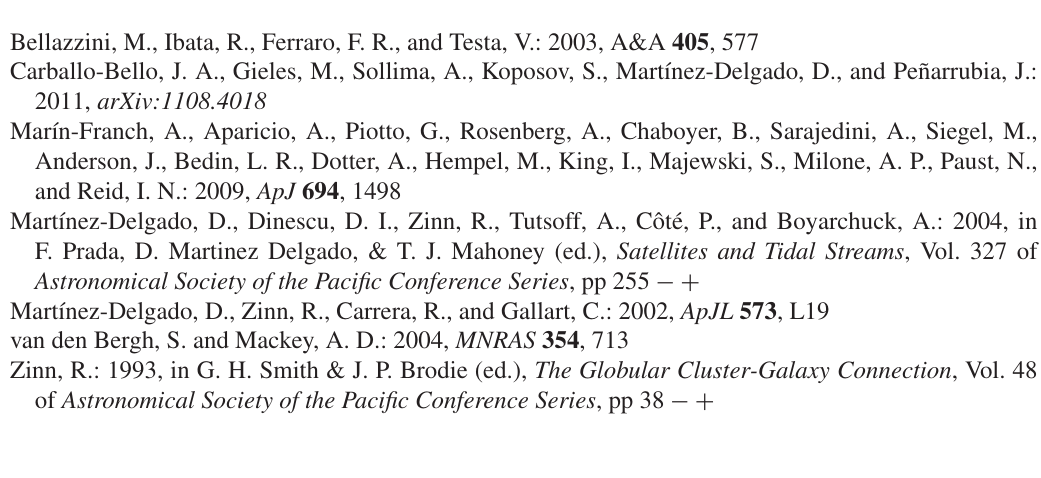
stellar population associated with the Sagittarius tidal stream with a compatible distance with